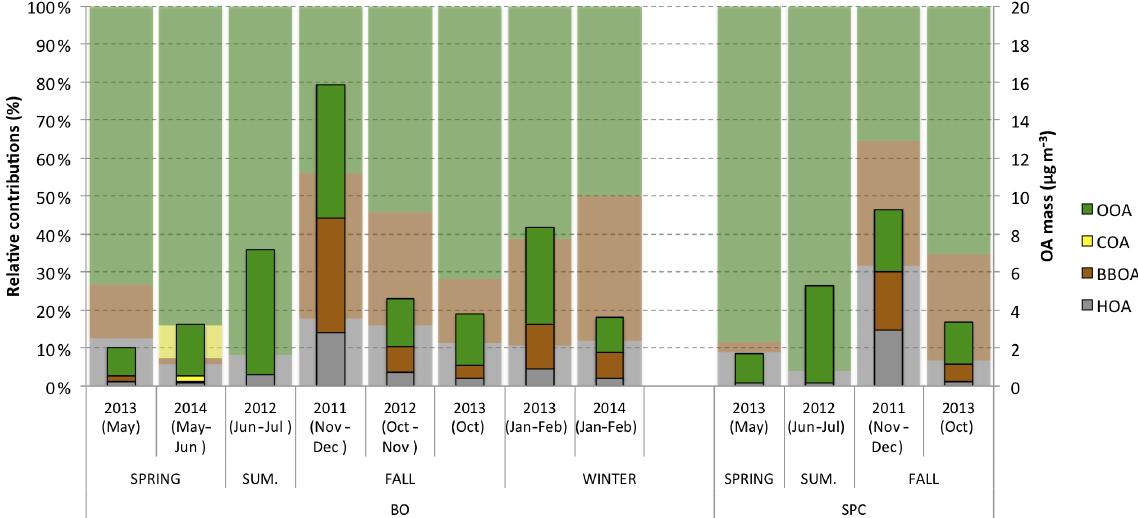
Figure 5. Organic aerosol source contributions for each site and each Supersito campaign. Relative contributions are shown as shaded histograms (referring to the left axis) in the background of the absolute ones (referring to the right axis).